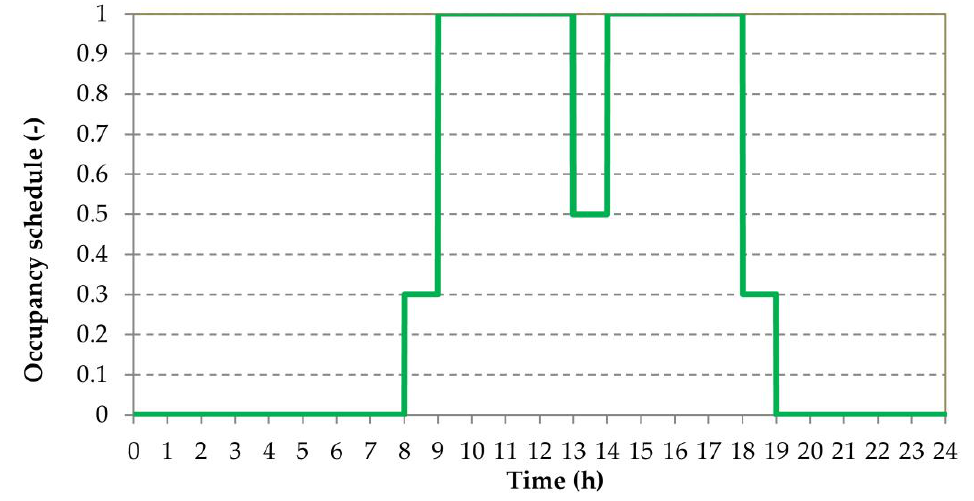
Figure 3. Occupancy schedule in a work day.